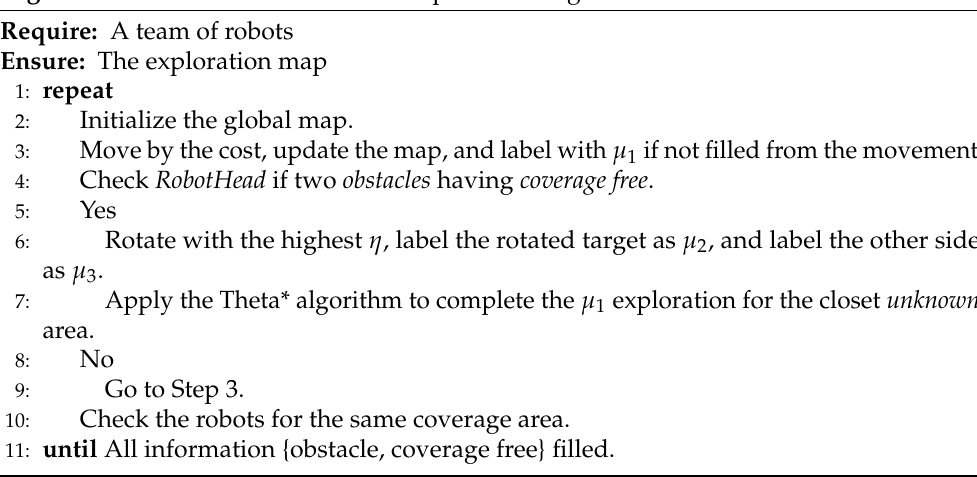
Algorithm 4 Advanced Multi-Robot Exploration